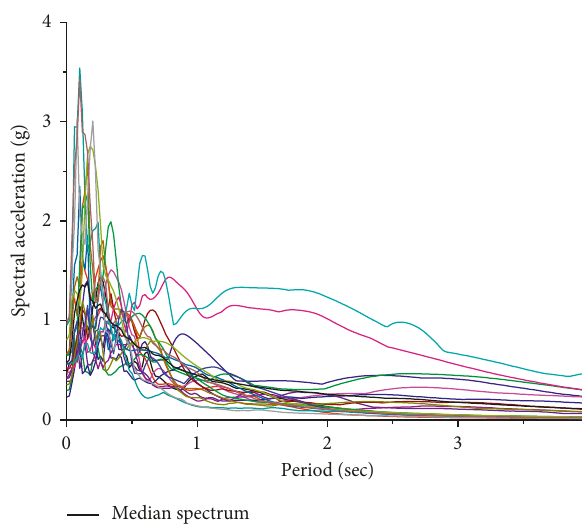
Figure 9: Responses spectra of SAC project ensemble for Los Angeles.